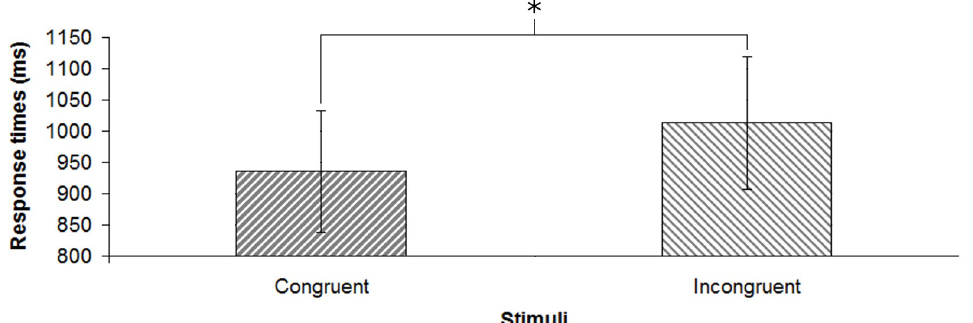
Fig 4. Response times for the two kinds of stimuli. Error bars show the standard error of the mean; � denotes statistical significance.